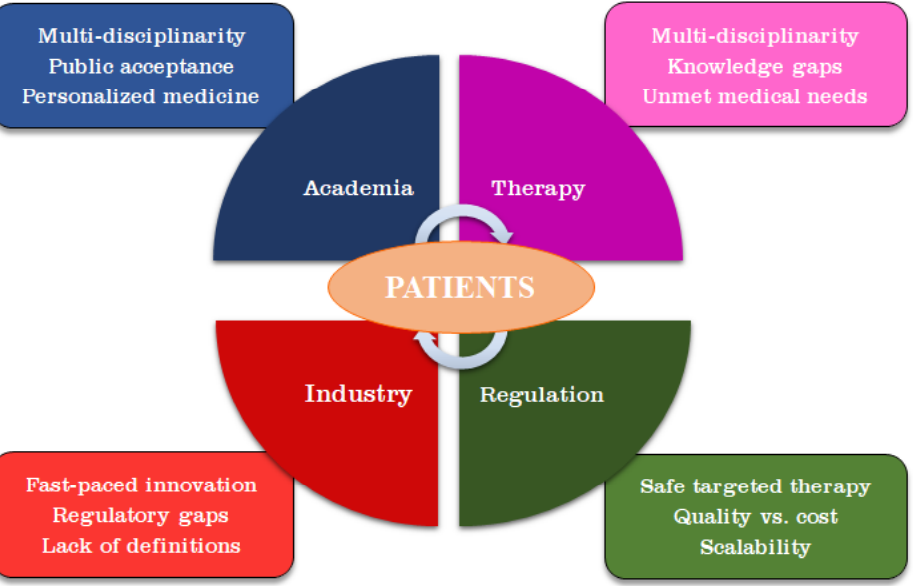
Figure 12. Stakeholders (academic researchers, clinicians and patients, industry, regulatory bodies) and the main challenges faced in the translation of nanomedicine.